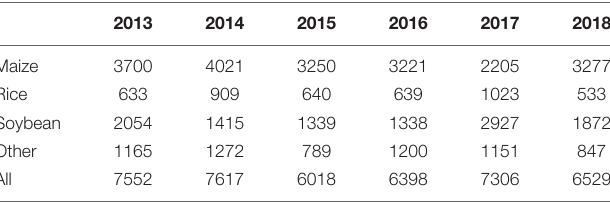
TABLE 1 | Statistics of ground reference samples from 2013 to 2018.